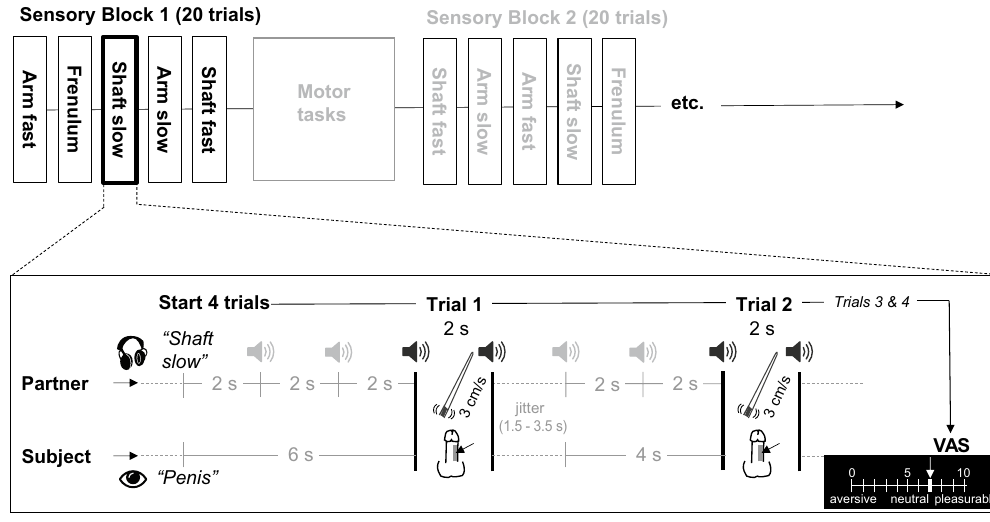
Figure 6. Schematic overview of the experimental task. Each sensory block consisted of 20 trials: 4 trials for each of the 5 stimulation types. Before the start of group of 4 trials, the stimulation site (forearm or penis) was presented to the subject on a screen. The partner received auditory cues indicating both the upcoming stimulation site (forearm, penile shaft, or penile frenulum) and velocity (CT-targeted or non-CT-targeted). The appropriate stimulation tempo was cued using high- and low-pitched beeps. Figure was created using Adobe Illustrator 2022 for Mac (v. 26.2.1; https:// www. adobe. com/ produ cts/ illus trator. html). Abbreviations: VAS, visual analogue